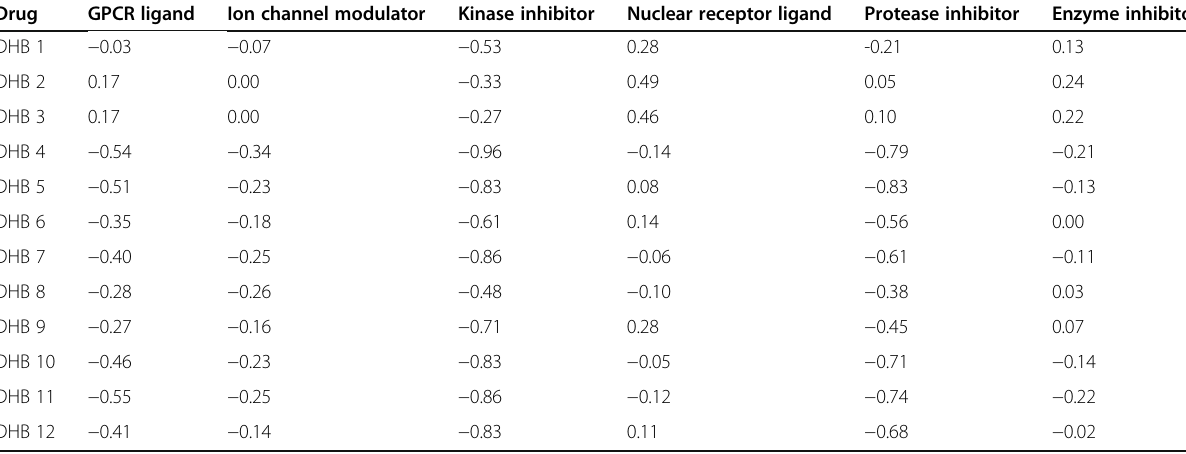
Table 1 Determination of drug likeness score of DHB through molinspiration online server Drug GPCR ligand Ion channel modulator Kinase inhibitor Nuclear receptor